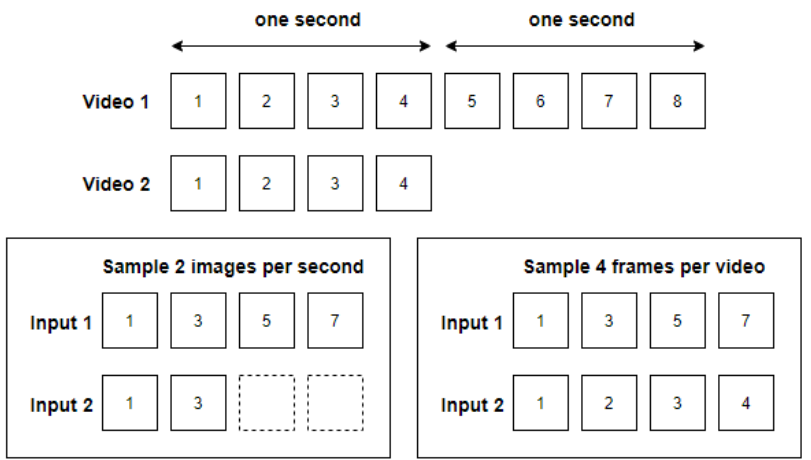
Figure 5. Comparison of two video sampling methods. Dotted rectangles indicate zero padding.